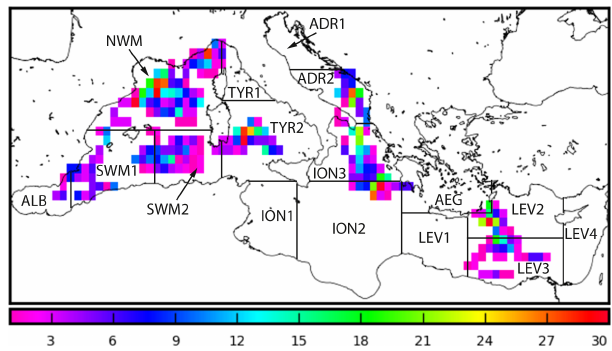
Figure 1. Spatial distribution of BGC-Argo float profiles superim- posed on subbasin division used in the Mediterranean Copernicus Marine Environment Monitoring Service (CMEMS)